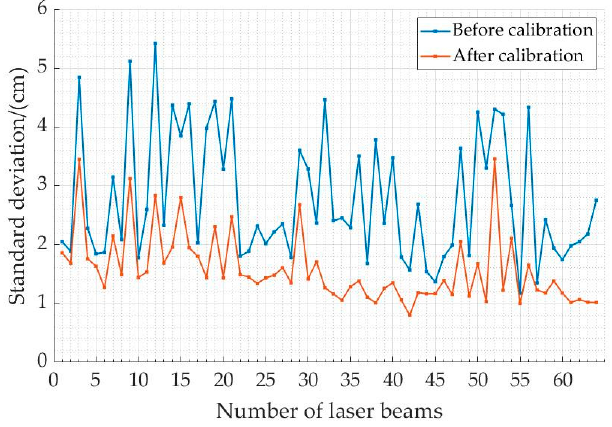
Figure 11. The SD of P2P-D before and after